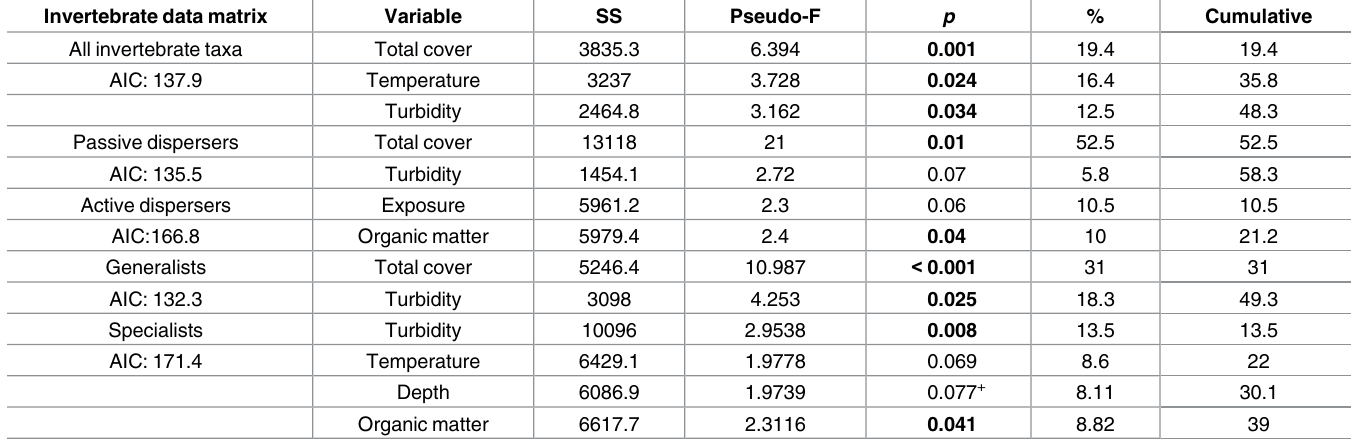
Table 3. Variation partitioning analysis (%) quantifying the sequential effects (stepwise selection, 9999 permutations) of the specific contribution of the environmental variables on the composition of the macrofauna community (significant results in bold at p (cid:20) 0.05). Total cover (algae +